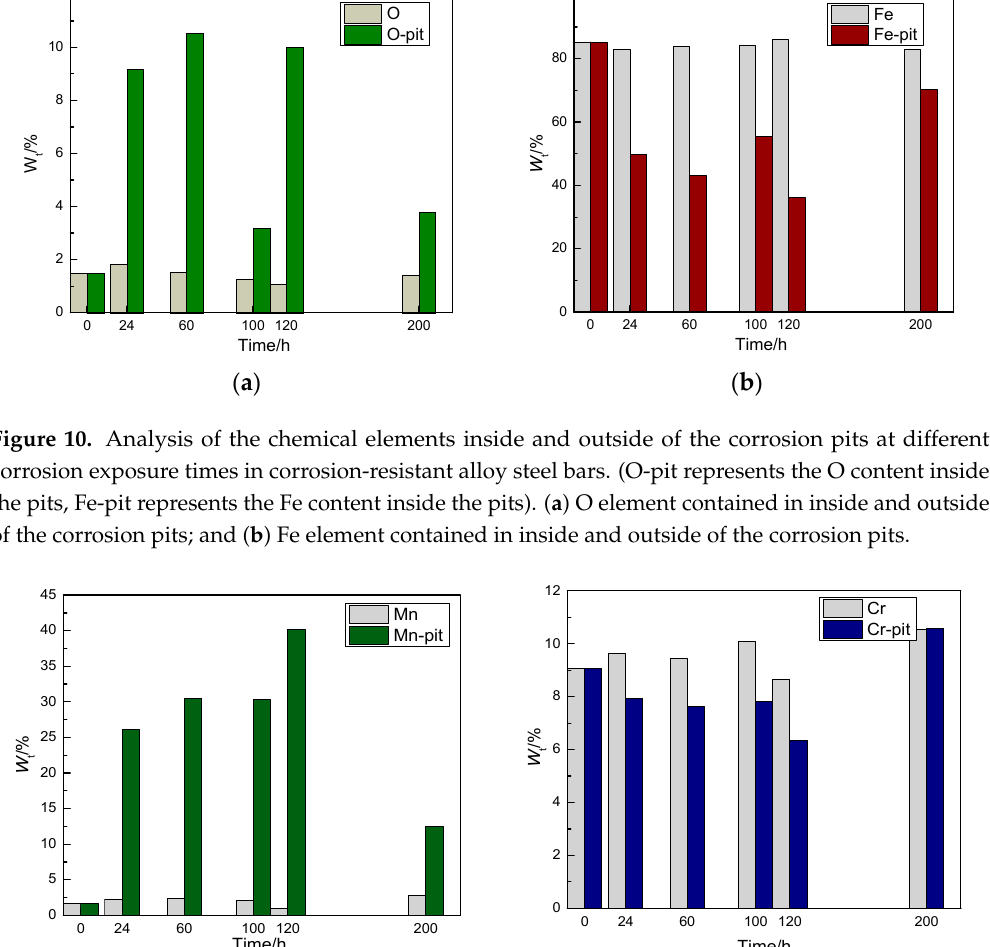
Figure 11. Contents of chemical elements inside and outside of the corrosion pits at different corrosion exposure times in corrosion-resistant alloy steel bars. (Mn-pit represents Mn content inside the pits, Cr-pit represents the Cr content inside the pits). ( a ) Mn element contained in inside and outside of the corrosion pits; and ( b ) Cr element contained in inside and outside of the corrosion pits.